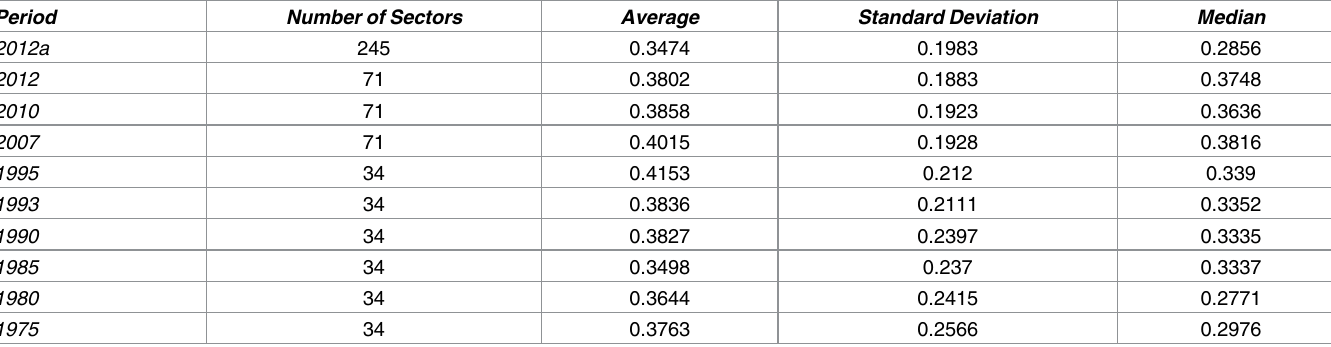
Table 1. Average, standard deviation, and median of the degrees of